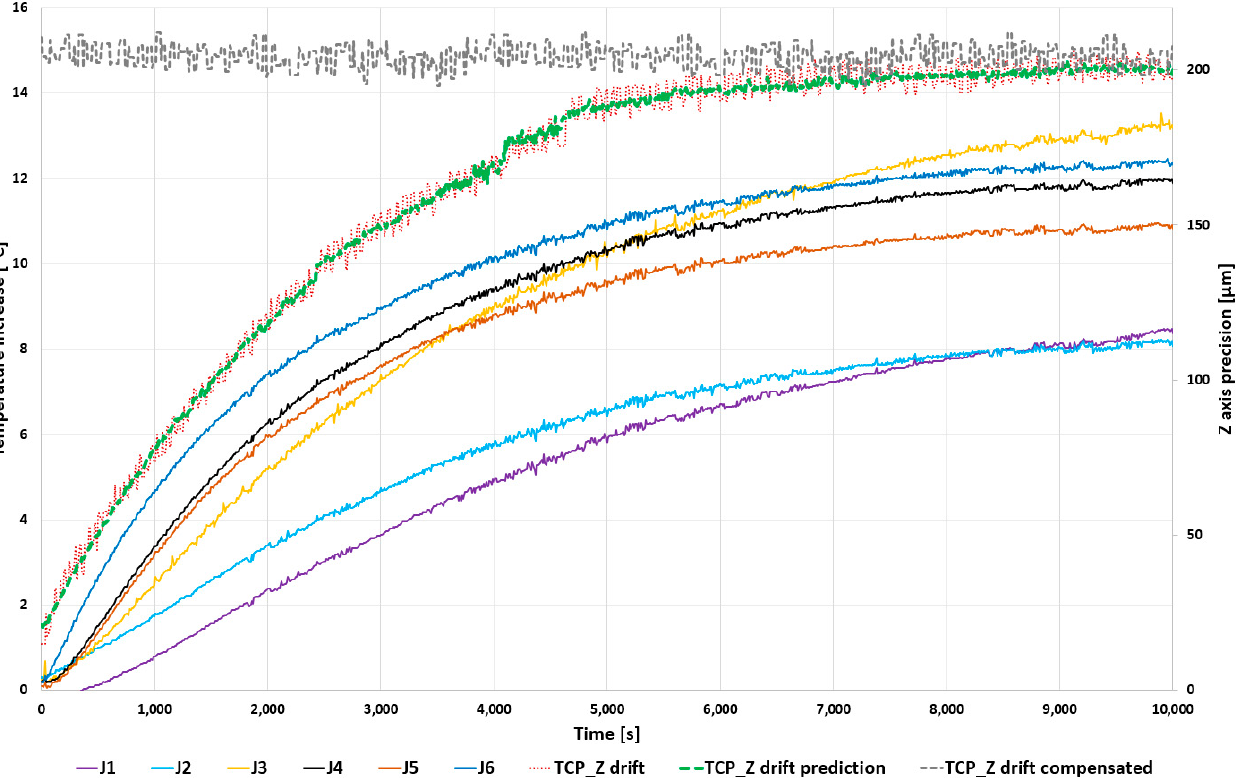
Figure 8. With and without drift compensation, Target 1, maximal speed. Data recorded during the initial measurement: purple—joint 1 temperature, light blue—joint 2 temperature, yellow—joint 3 temperature, black—joint 4 temperature, orange—joint 5 temperature, dark blue—joint 6 temperature, red dots express the uncompensated TCP Z-axis drift, green dots—TCP Z drift prediction based on MatLab regression learner and finally grey trend represents the TCP Z-axis drift with drift compensation applied.